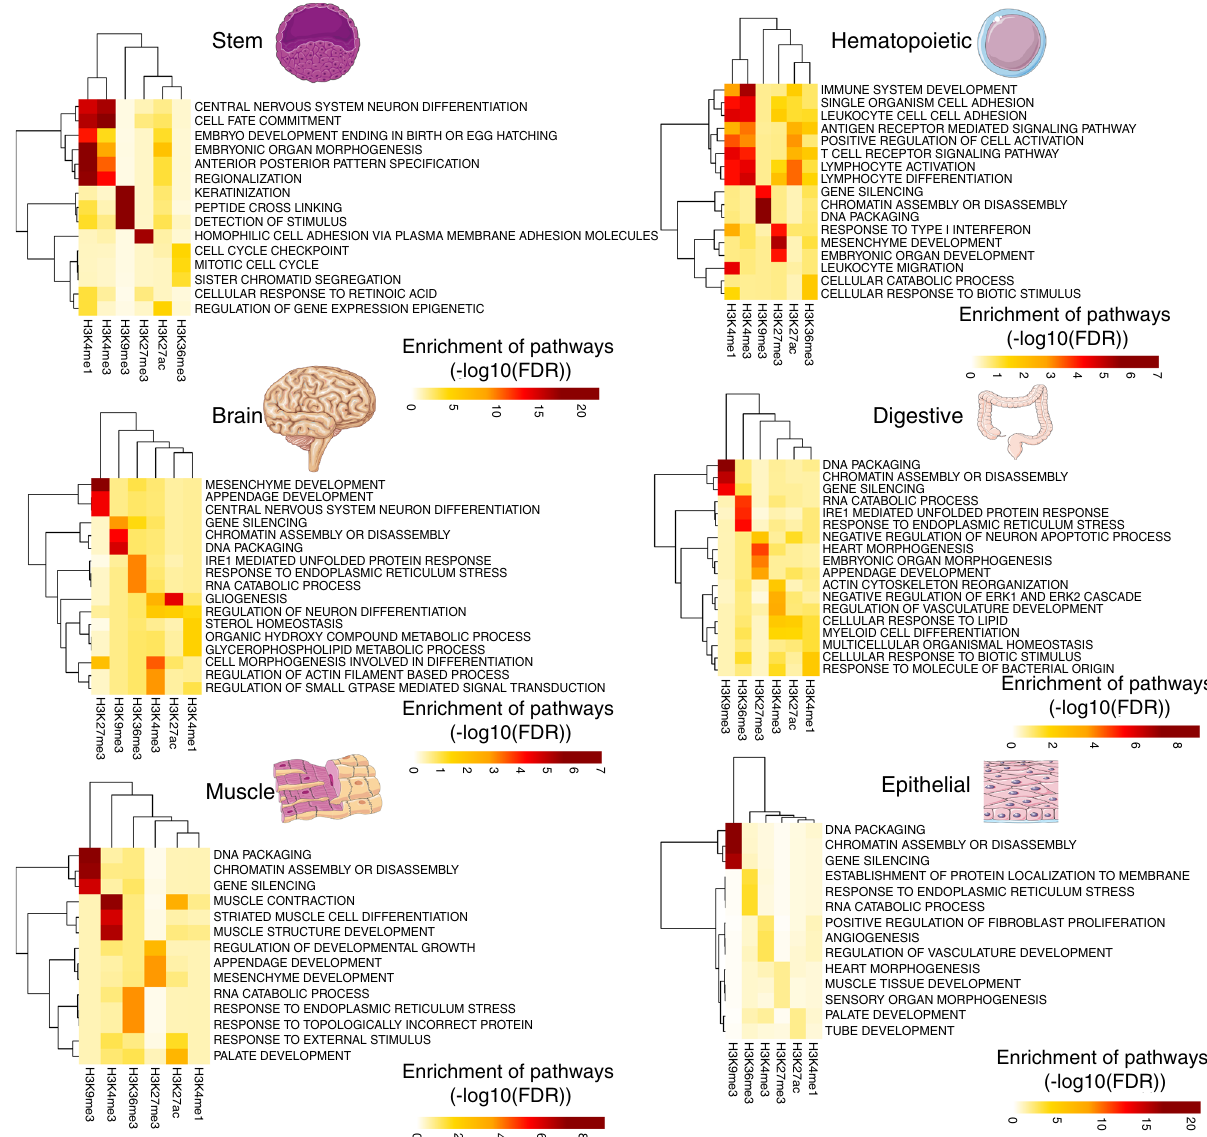
Fig. 3 Genes associated with LOCKs enrich for pathways related to the tissue of origin. Gene set enrichment analysis (GSEA) on the collection of genes found within LOCKs of various histone modi fi cations reveals pathways of relevance to stem, hematopoiesis, brain, digestive, muscle and epithelial tissues. In this analysis, the catalogue of genes associated with all the individual elements were used as background gene